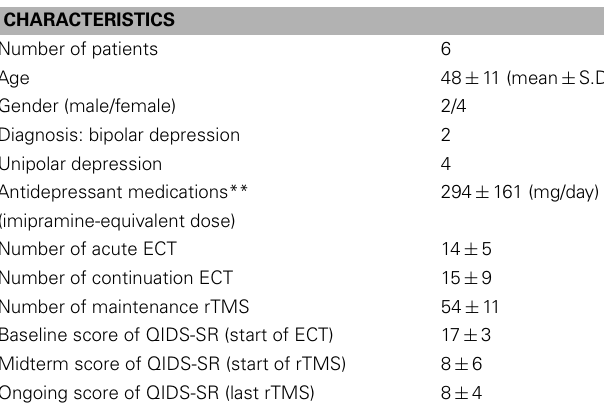
Table 1 | Clinical and demographic